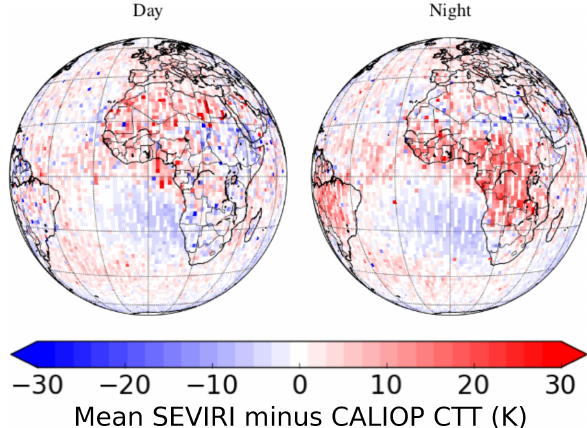
Figure A1. Spatial distribution of the bias in SEVIRI cloud top tem- perature retrievals during 2007, using a 15min collocation window. Biases are shown separately for the day (13:30LST CALIOP over- pass) and night (01:30LST CALIOP overpass).